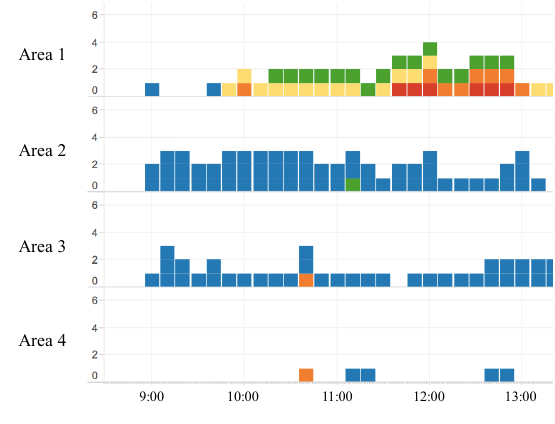
Figure 5. Time series analysis